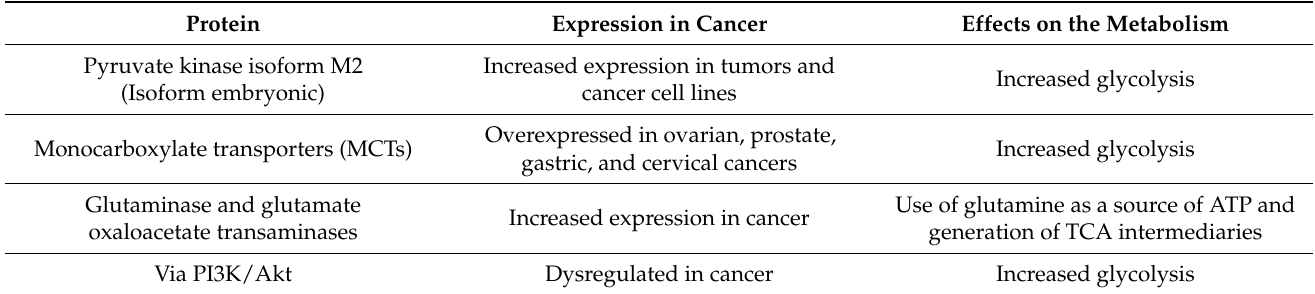
Table 1. Metabolic effects of the main proteins in cancer cells. Adapted with permission from Valle-Mendiola and Soto-Cruz